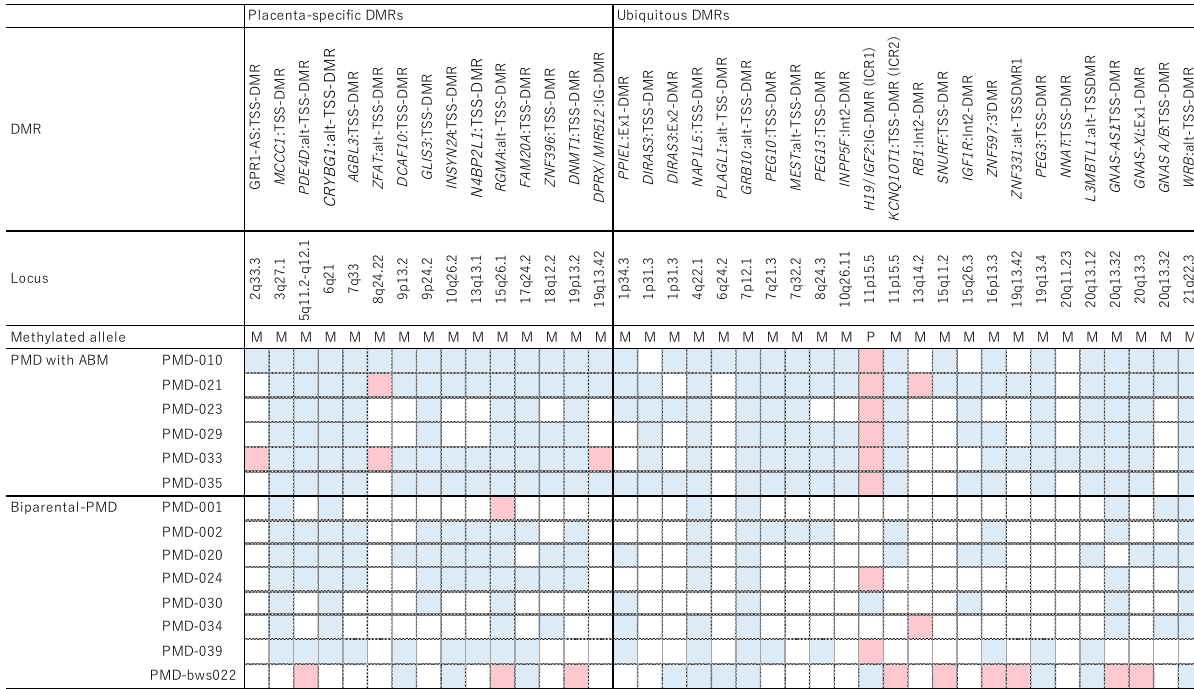
Figure 3. We performed a DNA methylation analysis of gametic DMRs, including 15 placenta- specific and 36 ubiquitous DMRs, in six specimens of PMD with ABM and eight biparental-PMD specimens [28]. Representative results from all 15 placenta-specific DMRs and 24 of the ubiqui- tous DMRs are shown. Seven placenta-specific DMRs ( MCCC1 :TSS-DMR, CRYBG1 :alt-TSS-DMR, AGBL3 :TSS-DMR, GLIS3 :TSS-DMR, INSYN2A :TSS-DMR, N4BP2L1 :TSS-DMR, and FAM20A :TSS- DMR) were aberrantly hypomethylated, which was defined as aberrantly hypomethylated but not aberrantly hypermethylated in more than half of the specimens (i.e., four or more of the biparental- PMD specimens). Aberrant hypomethylation was also observed at ubiquitous DMRs, including GRB10 :alt-TSS-DMR, but not at ICR1 or ICR2. NAP1L5 :TSS-DMR and WRB :alt-TSS-DMR were also frequently hypomethylated in biparental-PMD specimens, but the genes associated with these DMRs may not be involved in the pathogenesis of biparental PMD because normal-sized placentas were found in mice with two paternal copies of NAP1L5 and there was no correlation between WRB expression and DMR methylation in human placentas [79,80]. M, maternal allele; P, paternal allele. Pale blue shading indicates hypomethylation (<mean of normal − 2SD) and pink shading indicates hypermethylation (>mean of normal + 2SD). This figure was modified with permission from Aoki et al.